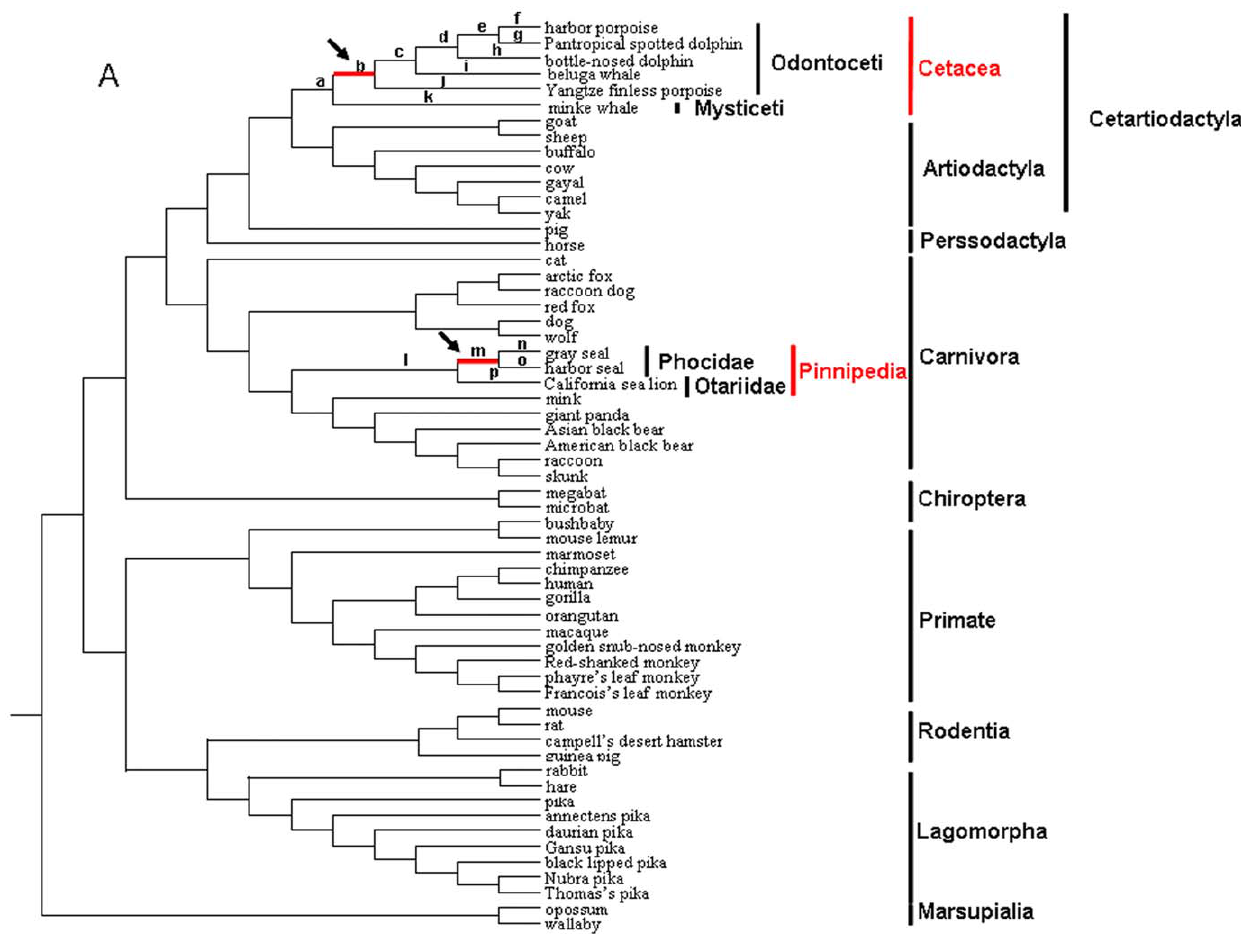
Figure 1. Phylogenetic trees of leptin gene used for codon-based maximum likelihood analysis in PAML. Tree topology corresponds to those from Murphy et al. (2001a) and Vogel (2005). Use of the alternative trees (Murphy et al. 2001b, 2007; Springer et al. 2004; Beck et al. 2006) gave essentially the same results. Branches a–p in the tree are used in the branch-site models tests. The thick and red branches (branches b and m) are those with significant evidence of positive selection in PAML analyses.